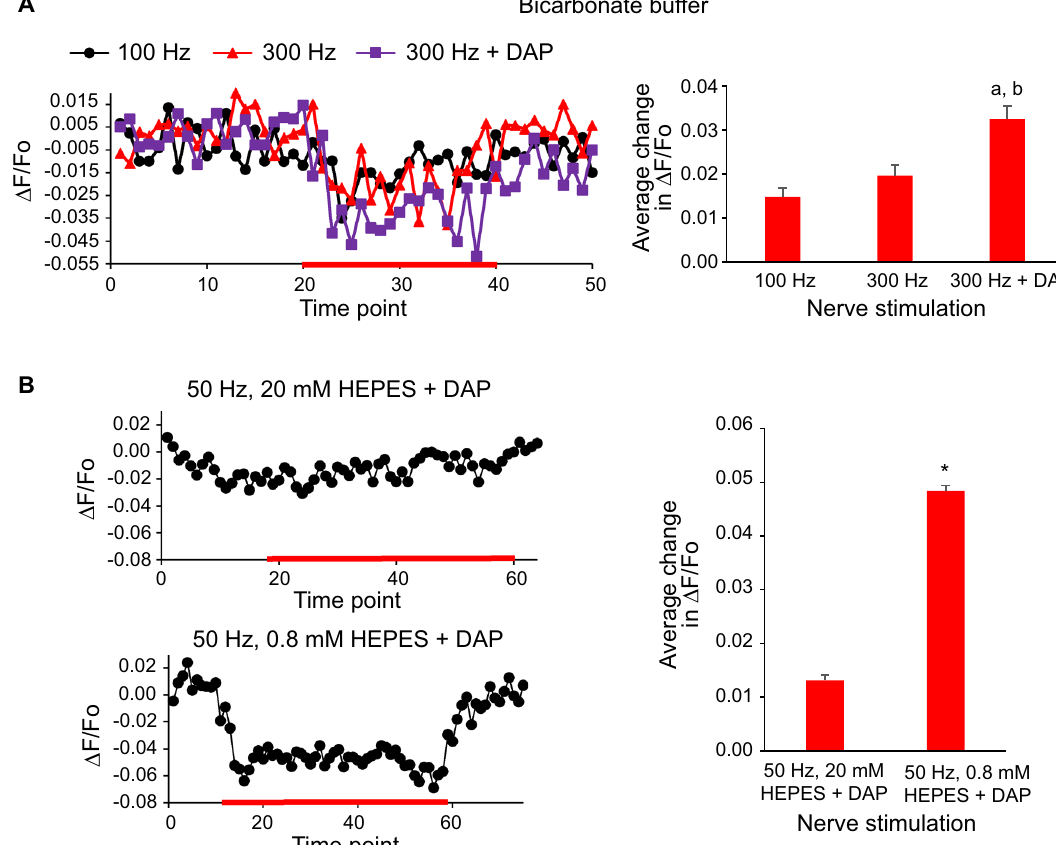
Figure 3. A Left: examples of NMJ fluorescence intensity changes before, during and after nerve stimulation at 100, 300 Hz and 300 Hz plus 100 µM DAP. The red line indicates the interval during which the nerve was stimulated. Right: the average changes in NMJ fluorescence intensity were calculated for each type of nerve stimulation. Letters indicate significant differences (Student’s t-test): a. p < 0.01 compared to stimulation at 100 Hz. b. p < 0.01 compared to stimulation at 300 Hz. B Left: comparison of NMJ fluorescence intensity changes during nerve stimulation at 50 Hz at the indicated HEPES buffer concentrations in the presence of 100 µM DAP. Right: the average changes in NMJ fluorescence intensity were calculated for each type of nerve stimulation. * p < 0.01 compared to stimulation in 20 mM